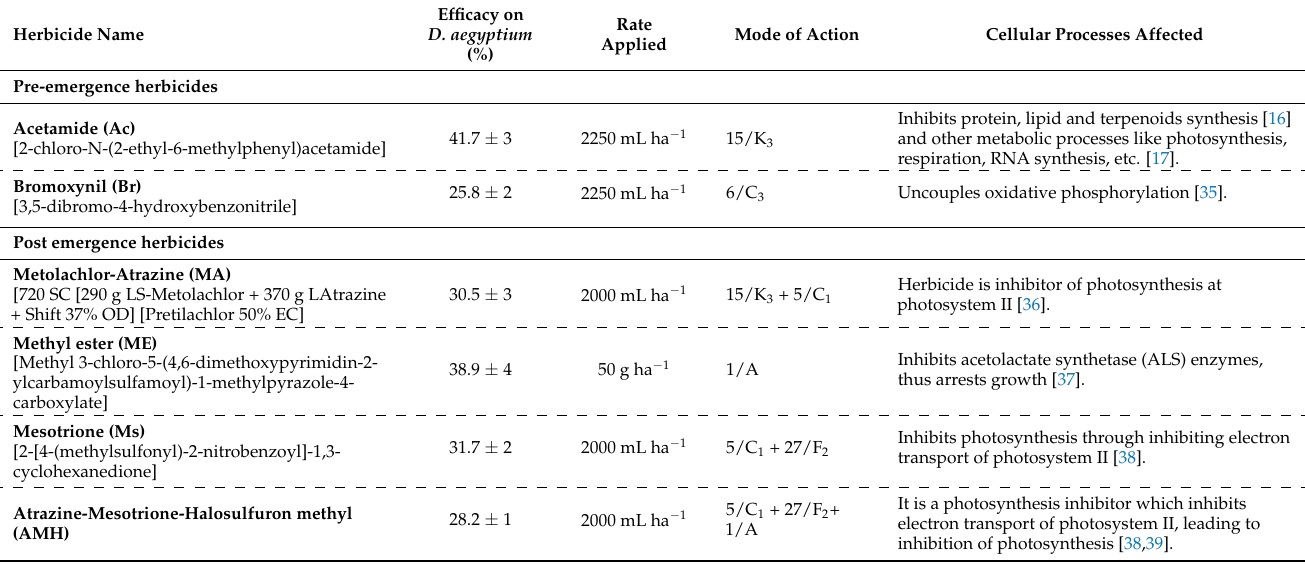
Table 1. Generic names and mode of action of various pre- and post-emergence herbicides sprayed on Dactyloctenium aegyptium (L.)